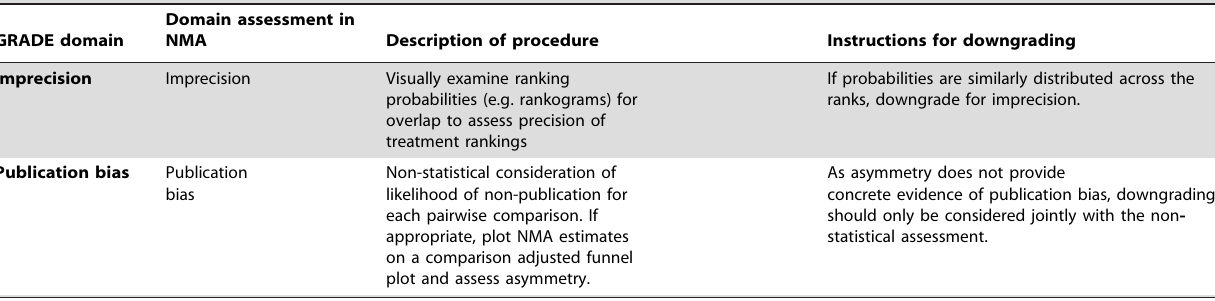
Evaluate the confidence in a specific pairwise effect estimated in network meta-analysis GRADE domain